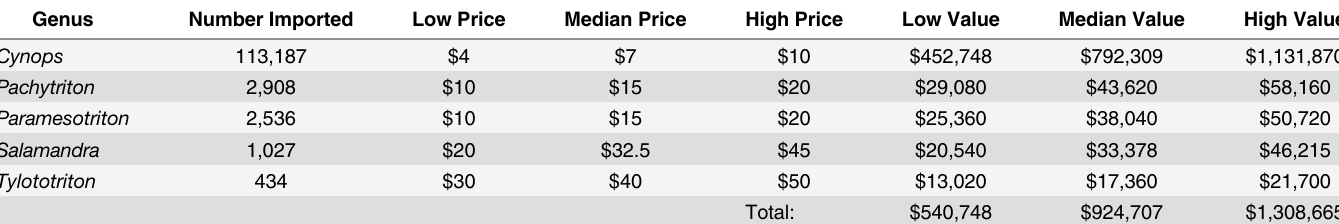
Table 1. Estimated annual value (USD) of salamanders imported into the US based on 2014 imports (see S1 Table) and a range of market values (low, median, and high). Genus Number